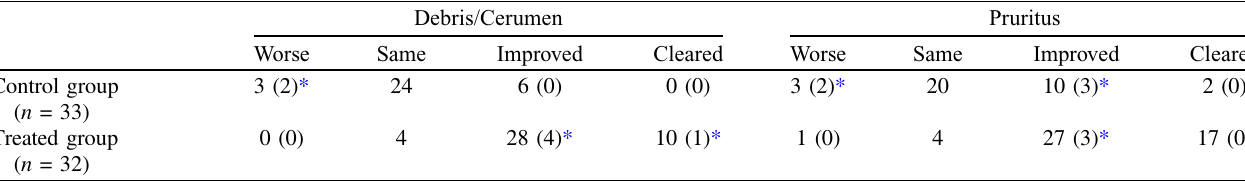
Table 4. Course of otitis signs in the Field study, one month after